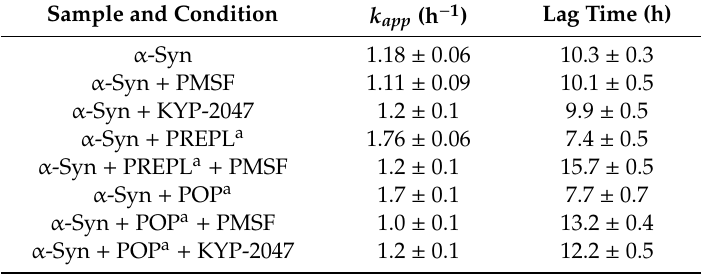
Table 1. Growth rate constant and lag time parameters for α -Syn fibril formation, monitored by ThT fluorescence over time, in the absence or in the presence of PREPL and POP ( − or + PMSF and − or